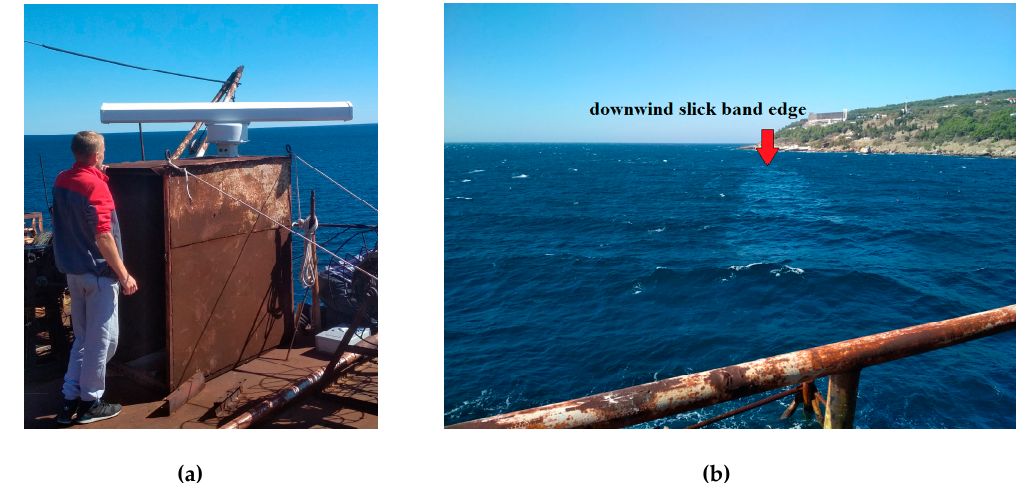
Figure 2. ( a ) The MRS-1000 radar installed on the SOP. ( b ) A photograph of an artificial slick band on the sea surface.